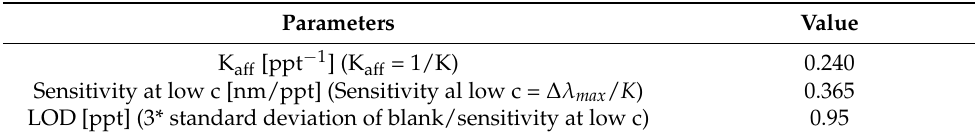
Table 4. Sensor chemical parameters for PFOA detection in seawater. Parameters